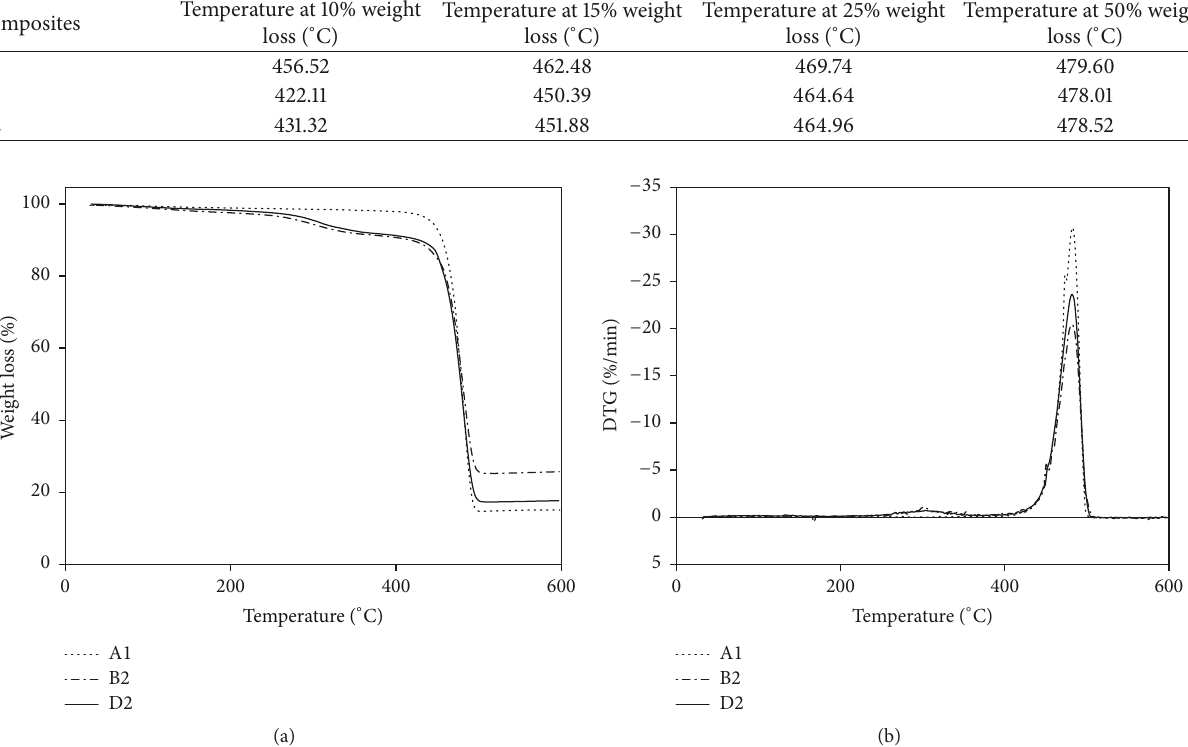
Figure 2: (a) Thermogravimetric analysis (TGA) thermogram. (b) Differential thermogravimetric graphics (DTG) thermogram of composites types A1, B2, and D2.